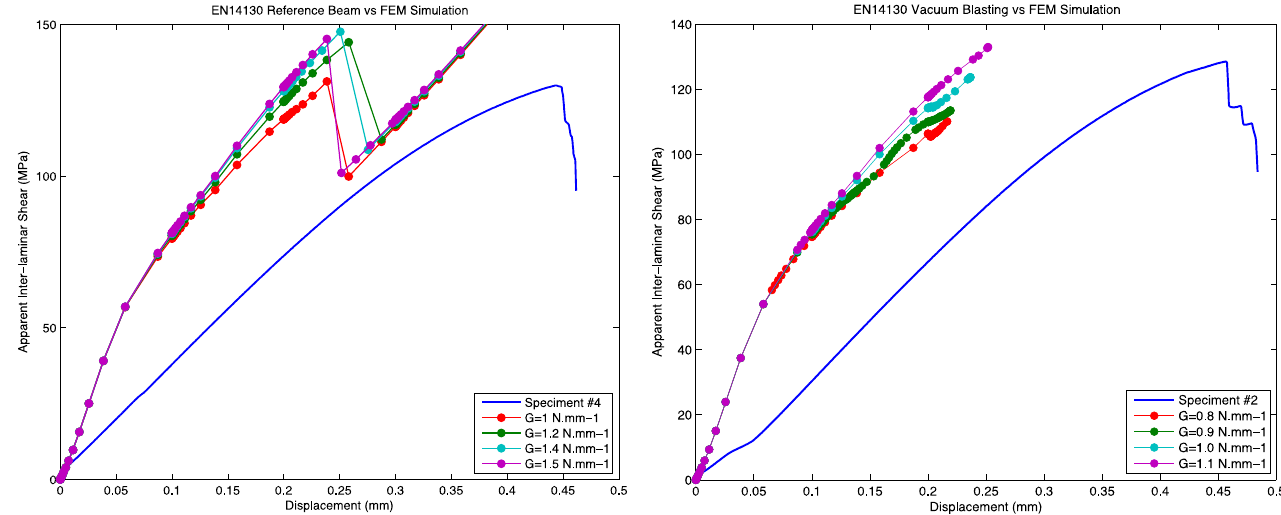
Figure 8: Reference beam. Comparison between numerical and experimental results (specimen #4).